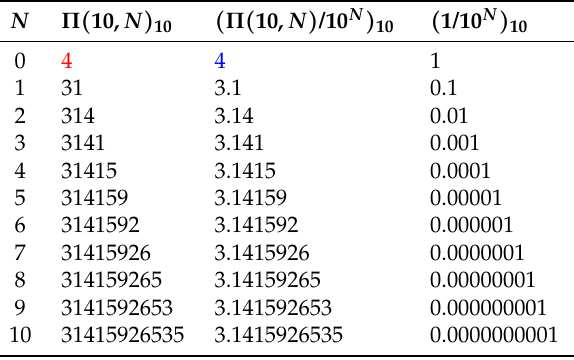
Table 1. Number of collisions Π ( 10, N ) given by Equation (13) for the decimal base, b = 10. The first column reports the value of mantissa N . The second column is the resulting number of collisions in the decimal base. The third column is the number π with N digits in the fractional part in the decimal representation. The fourth column gives the systematic error according to Equation (55). The case where approximation (14) fails as compared to (13) is highlighted by red. The blue digit is incorrectly predicted by the Galperin billiard. N Π ( 10, N ) 10 ( Π ( 10, N ) /10 N ) 10 ( 1/10 N )